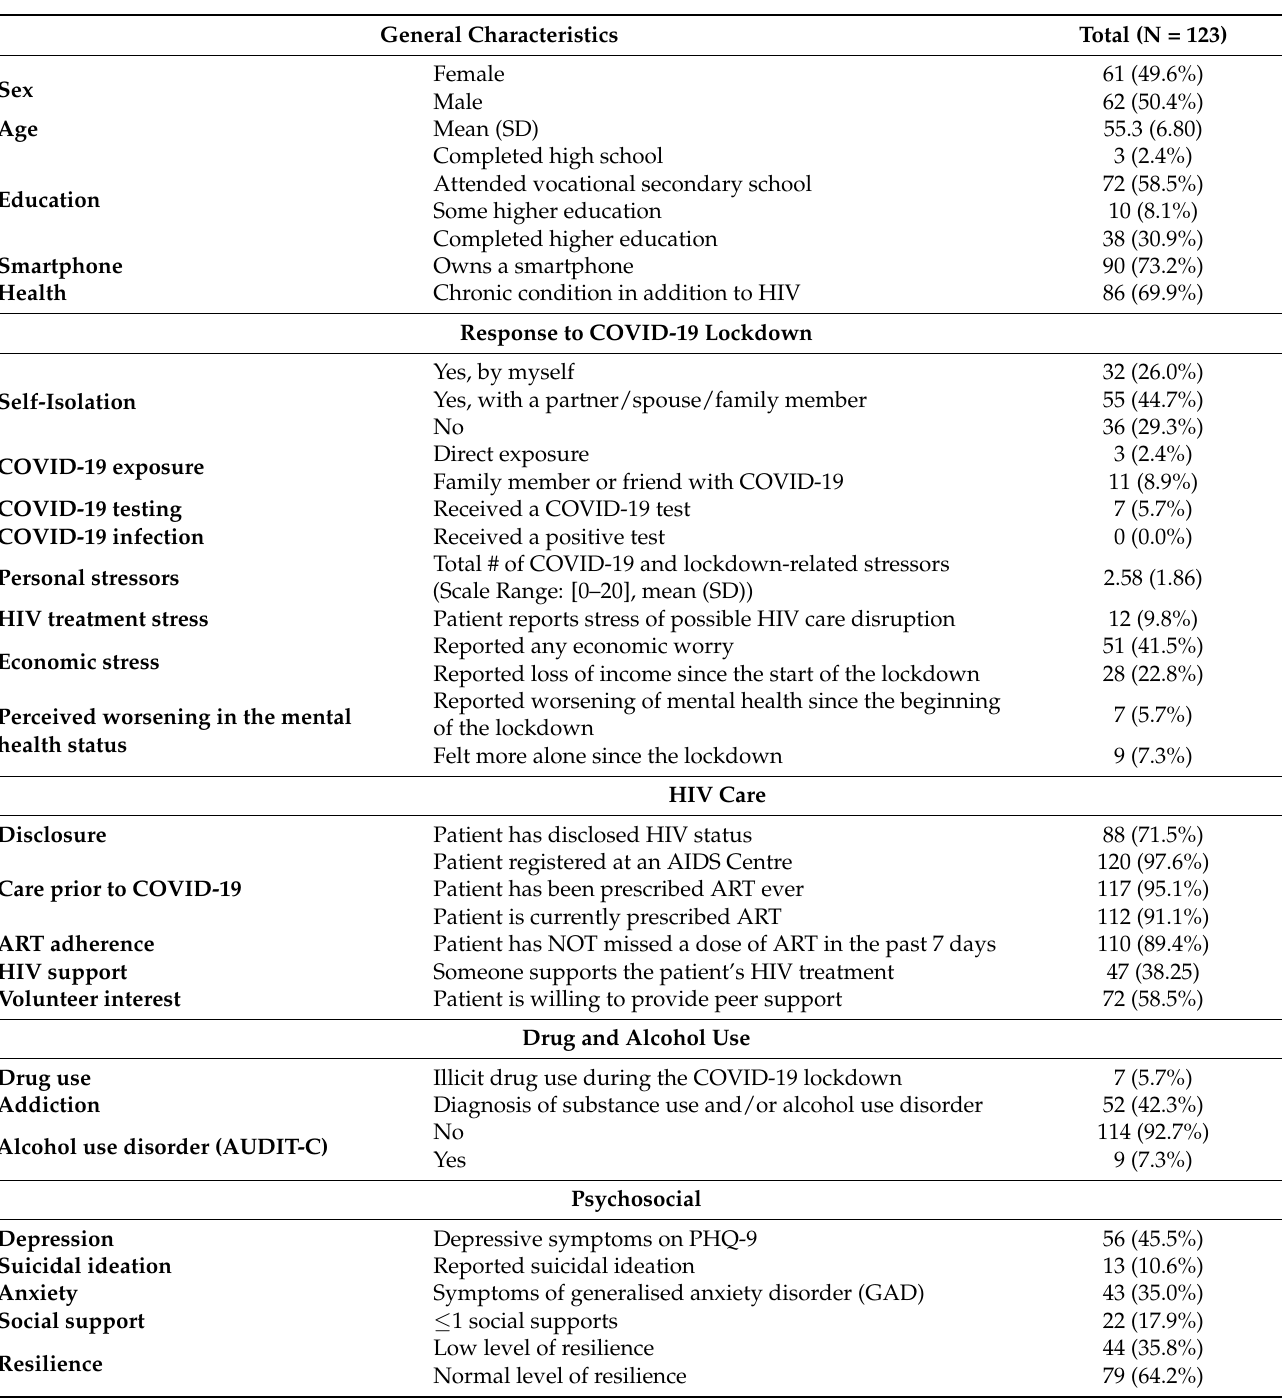
Table 1. Characteristics of older people with HIV (N =